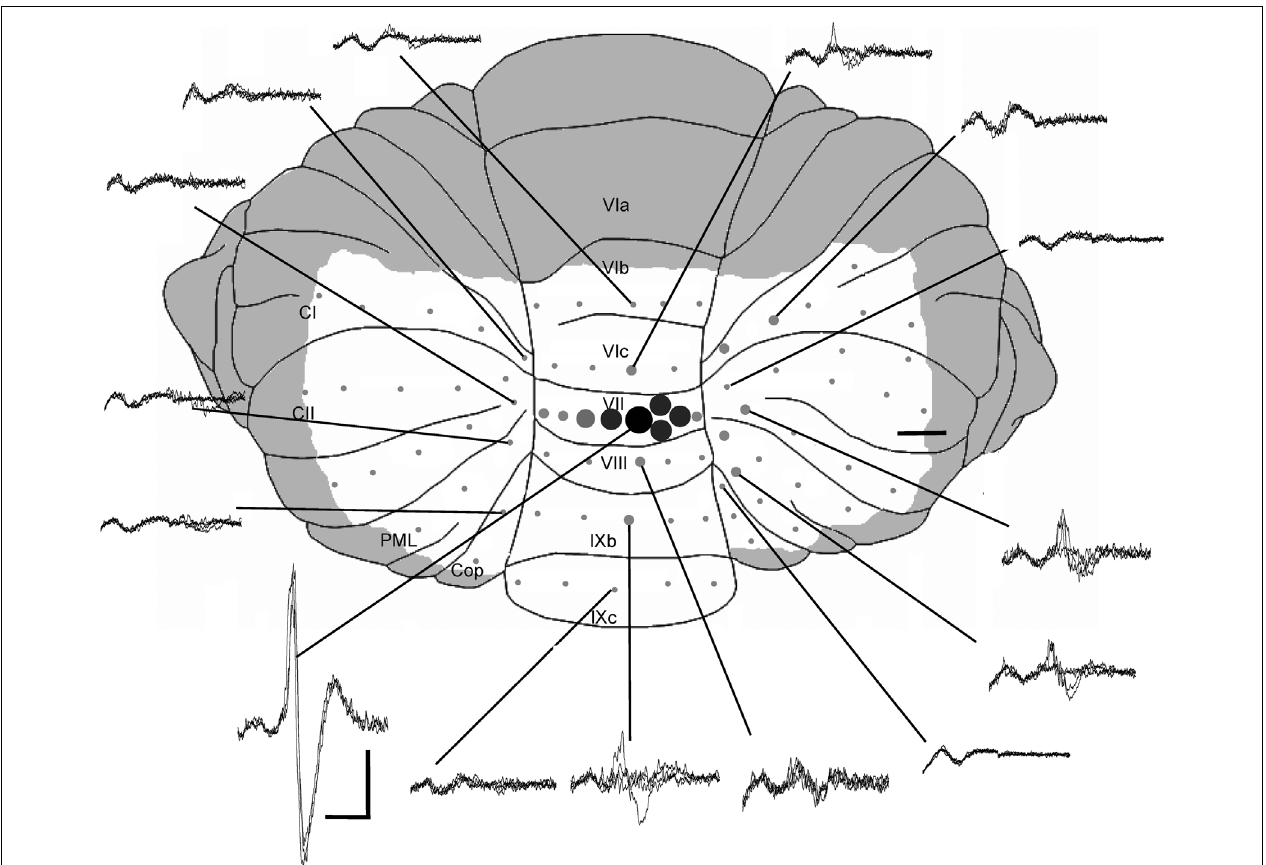
FIGURE 1 | Mapping of cerebellar fi eld potentials. Dorsal view of the rat cerebellum illustrating the distribution of responses evoked by stimulation of left PrL at intensity 2T in one experiment (case 31). Example waveforms (superimpositions of four consecutive responses) are shown of the largest responses recorded on the surface within each cerebellar region. Approximate peak-to-trough amplitude is represented by the size of circles.